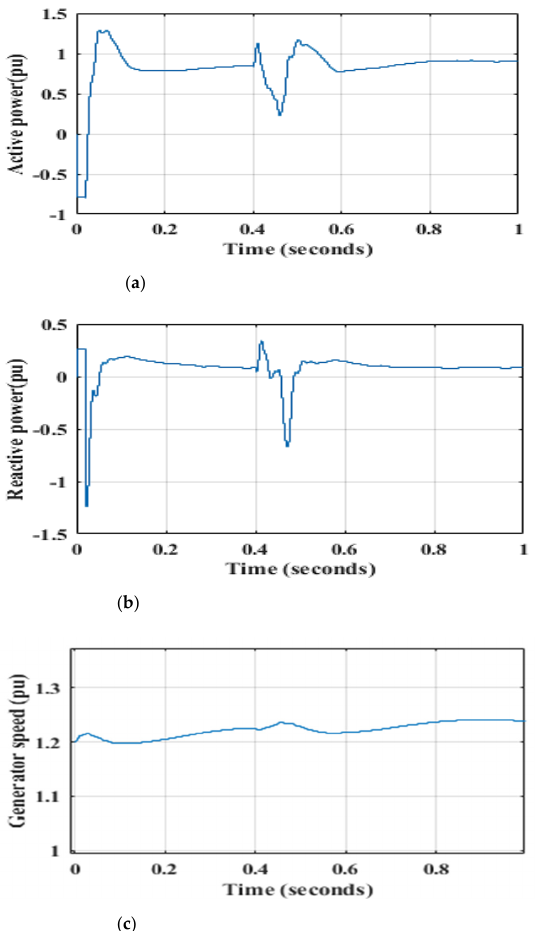
Figure 14. The DFIG responses according to the scenario I ( a ) measured active power of DFIG WT, ( b ) measured reactive power of DFIG WT, ( c ) Generator speed of DFIG system.